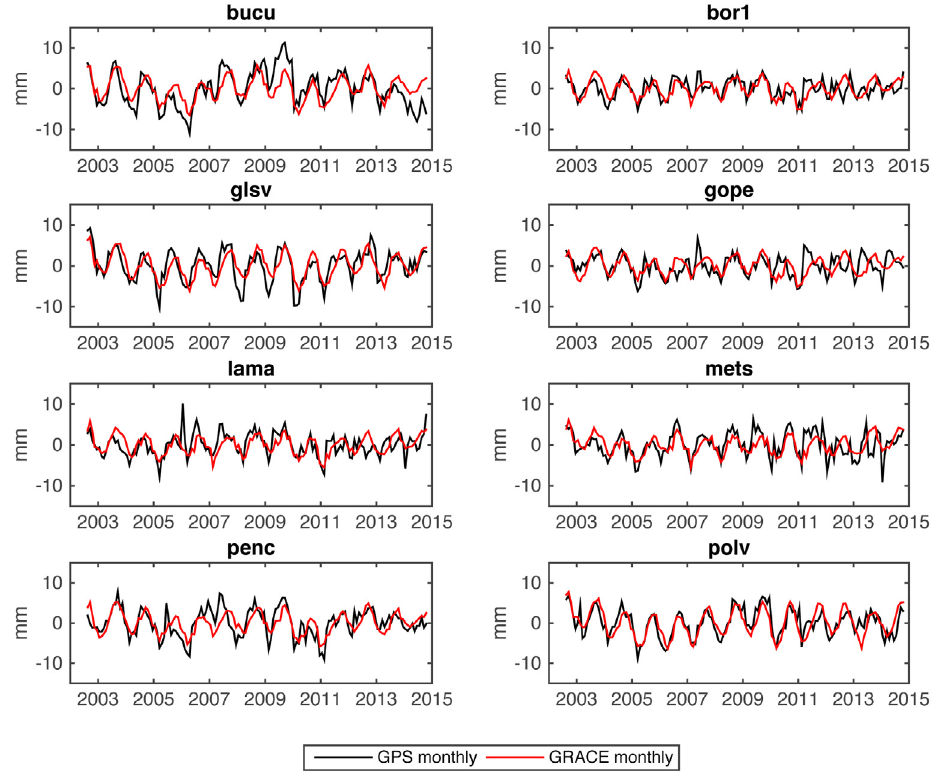
Figure 2. Comparisons of monthly GPS height residuals and GRACE-derived vertical displacements at 8 selected GPS sites. Atmospheric and oceanic loading effects have been removed from both GPS height residuals (black curves) and GRACE-derived vertical displacements (red curves), so the GPS and GRACE results here reflect hydrological loading deformation.